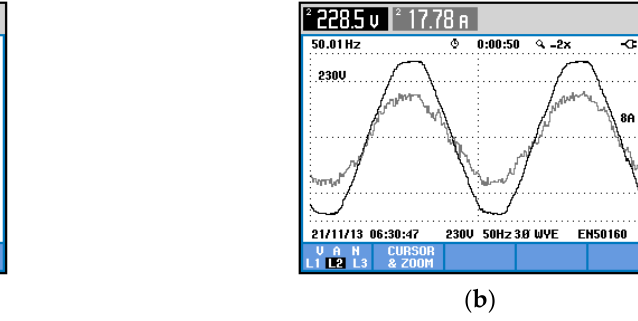
Figure 35. Case 3 - four-wire ShAPF operating with balanced voltages and balanced loads: ( a ) source power; ( b ) voltage and current waveforms in phase S .